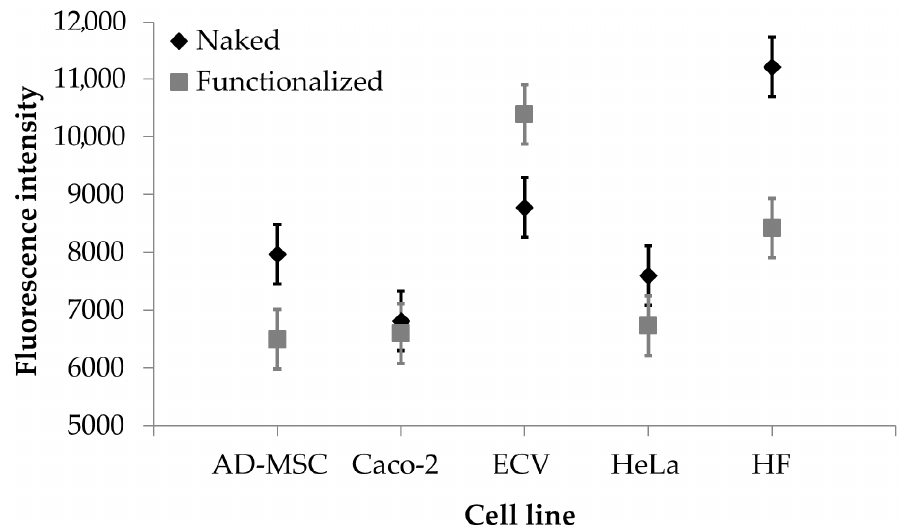
Figure 6. Cellular uptake results. Fluorescence intensity obtained after treatment with naked (black rhombuses) and functionalized (grey rectangles) SFNs (concentration 0.01 mg/mL). Data are reported as mean values and least significant difference (LSD) intervals, ANOVA. The overlap of two LSD intervals graphically indicates the absence of significant differences ( p > 0.05).